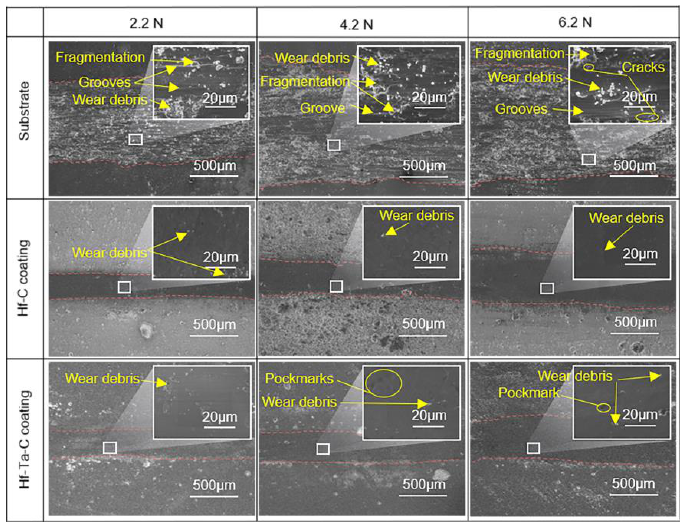
Figure 14. The surface morphology of wear scars of coatings and the substrate.